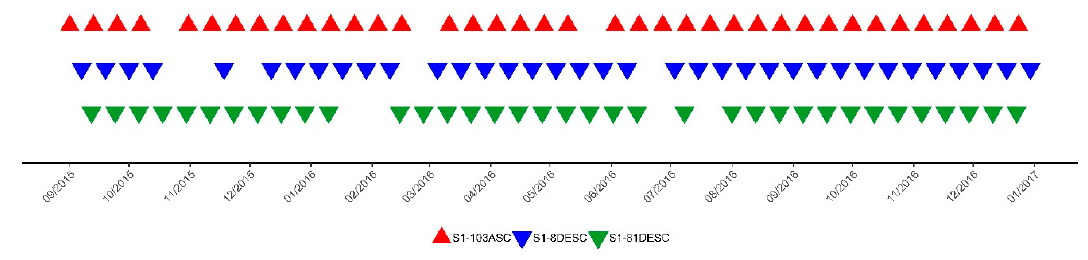
Figure 1. Acquisition dates of the Sentinel-1 observations used.